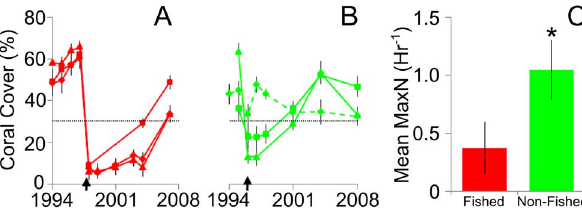
Figure 2. Coral cover and shark density at fished (red) and non- fished (green) reefs. Coral cover is shown for the (A) Scott Reefs and (B) Rowley Shoals, including reefs with (solid line) and without (dashed line) disturbance events. Arrows denote timing of disturbance and the dashed black line denotes the 30% coral cover threshold. (C) Shark density at fished and non-fished reefs measured as the maximum number of each species seen together at any one time (MaxN) per hour of tape. Values are the means 6 95% confidence intervals. * p , 0.05 for permuted t -test.